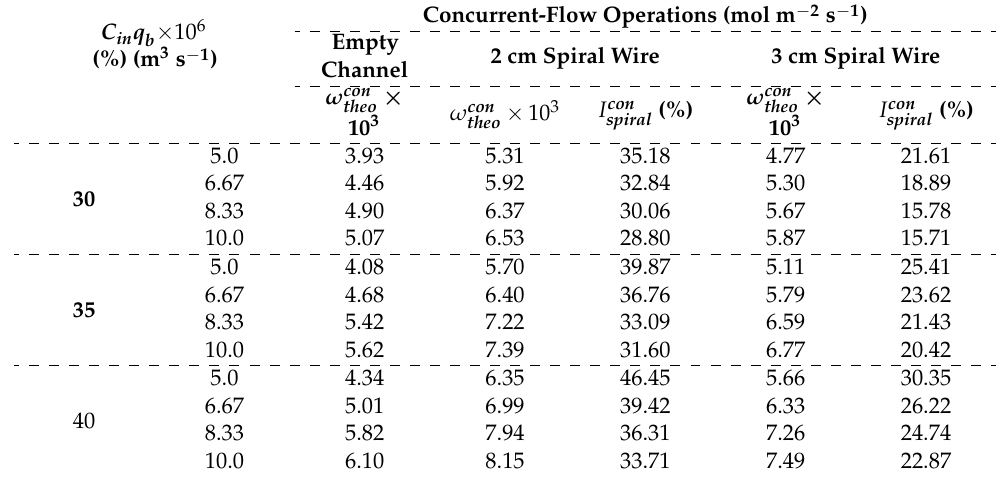
Table 2. Effects of spiral-wire pitches on absorption flux improvements. × 10 C in q b